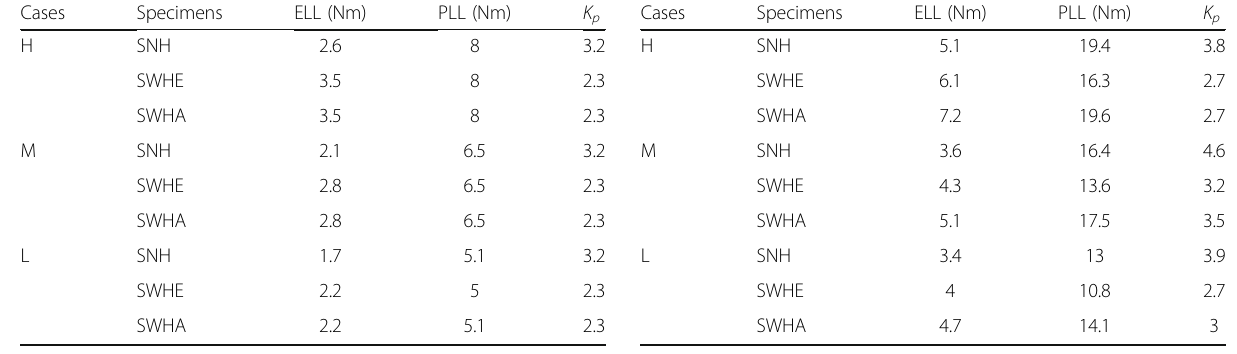
Table 7 Factor K p from 2D finite element analysis Cases